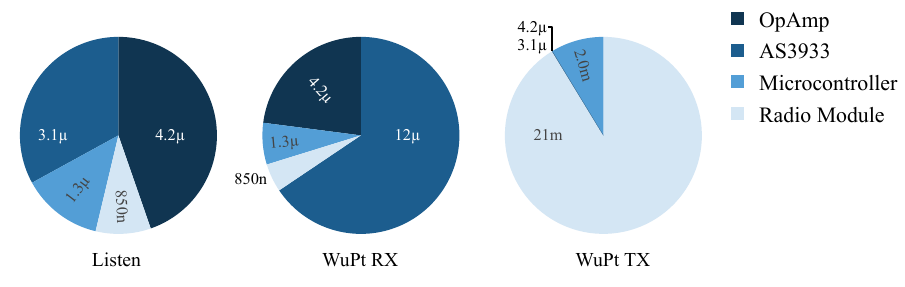
Figure 15. Current need of WuRx with TIA amplifier.